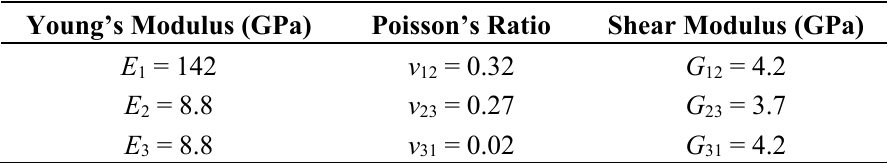
Table 2. Material properties of the unidirectional CFRP